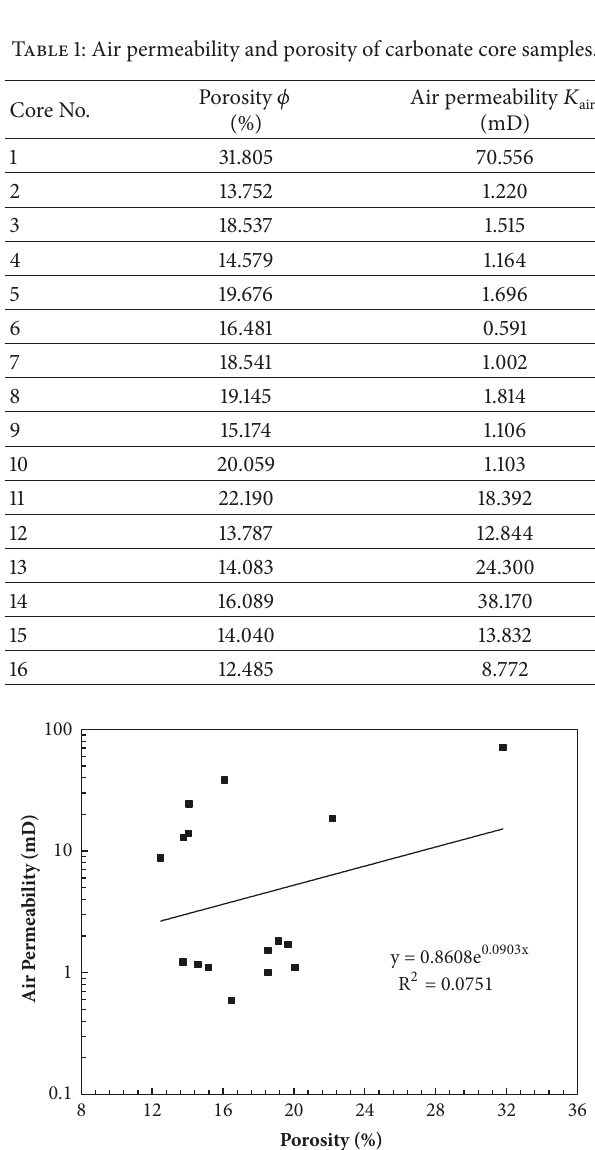
Figure 1: Porosity-permeability correlation of 16 carbonate core